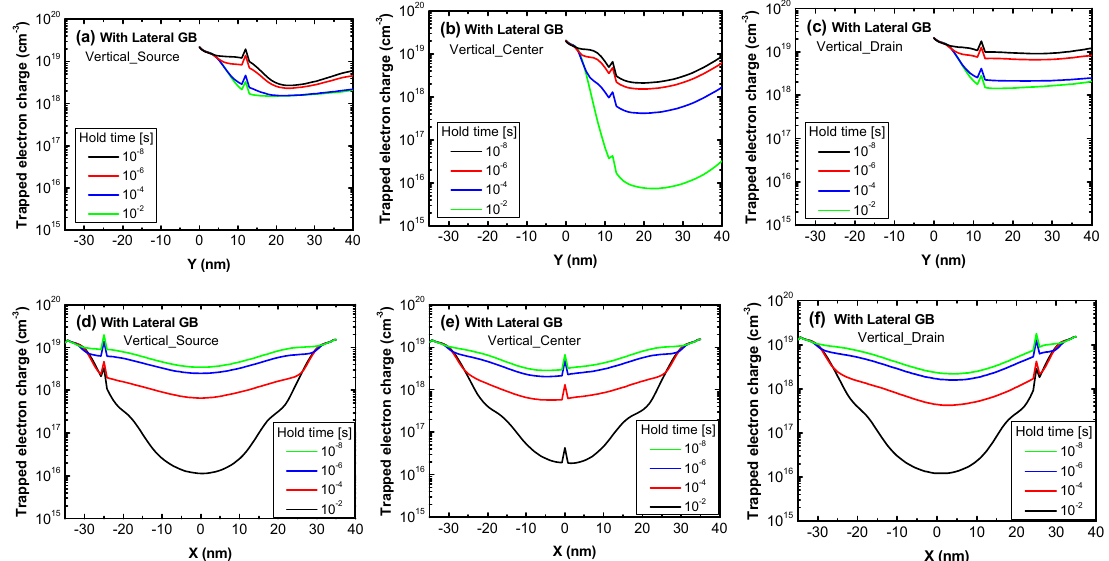
Figure 11. The trapped electron charge of poly-Si 1T-DRAM devices having a lateral GB in the Read “0” operation as a function of the position within ( a – c ) a vertical GB and ( d – f ) a lateral GB. The lines in each figure represent varied hold times to show their effect on the trapped electron charge. The devices are ( a ) and ( d ) Vertical_Source; ( b ) and ( e ) Vertical_Center; and ( c ) and ( f ) Vertical_Drain.